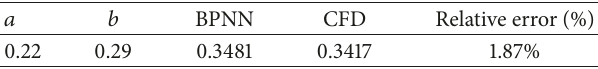
Table 5: Comparisons of the optimal drag ratio of the follower AUV between CFD and BPNN.